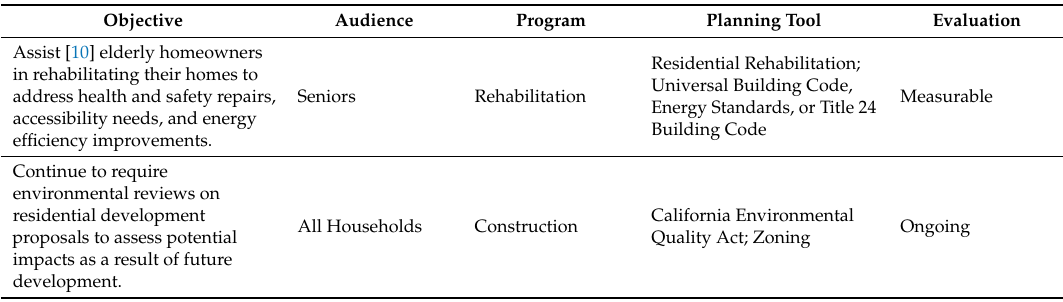
Table A1. Components of the plan quality measures. This table demonstrates how two objectives were assessed by the items in the protocol.